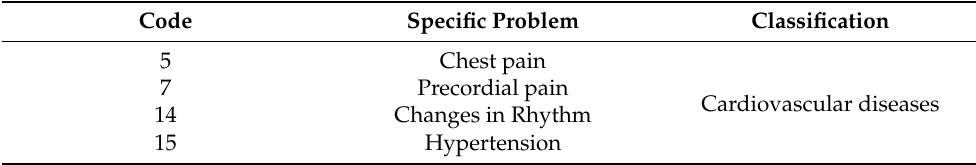
Table 3. Selected codes for cardiovascular